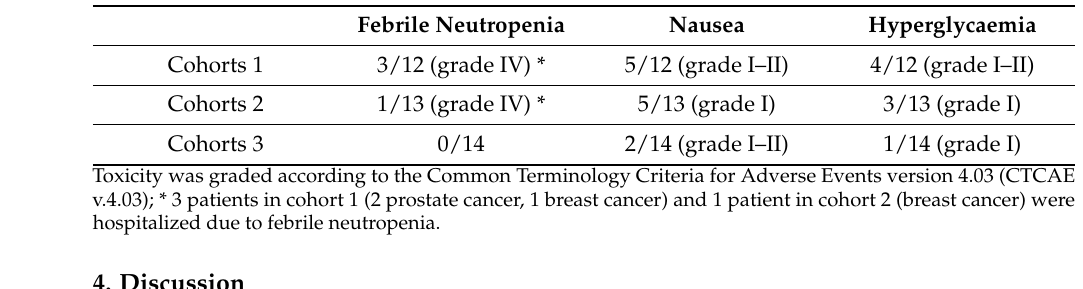
Table 4. Other toxicity of